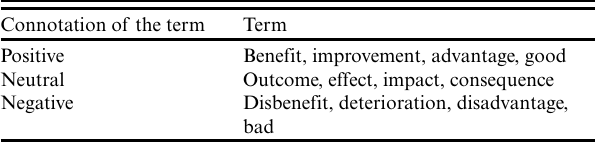
Table 1. Potential terminology for the effects of environmental